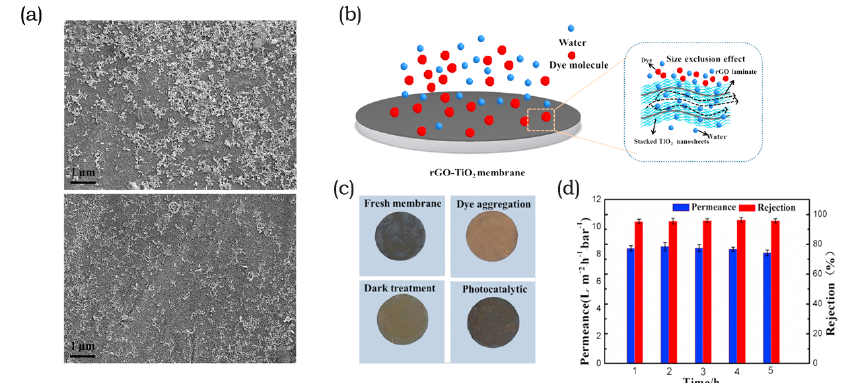
Figure 8. ( a ) Fouled membrane surfaces after testing: unmodified PPA membrane fouled by BSA (top); and, improved BSA fouling resistance of BN-modified PPA (bottom). Adapted from [203], Copyright (2019), with permission from Elsevier. ( b – d ) Illustration of a flat sheet nanosheet membrane separating dye molecules based on the sieving effect. The coloration of the flat sheet stacked rGO/TiO 2